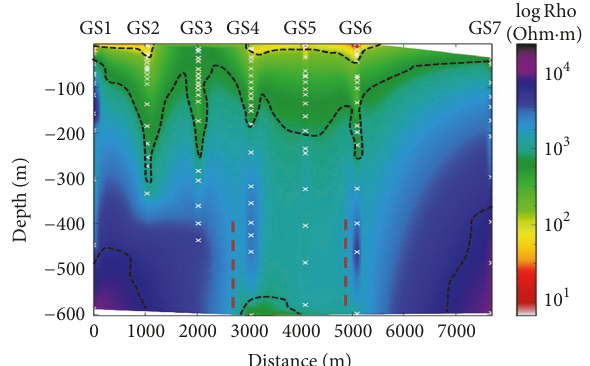
Figure 15: Geoelectrical section of Garga Sarali profile at 600 meters’